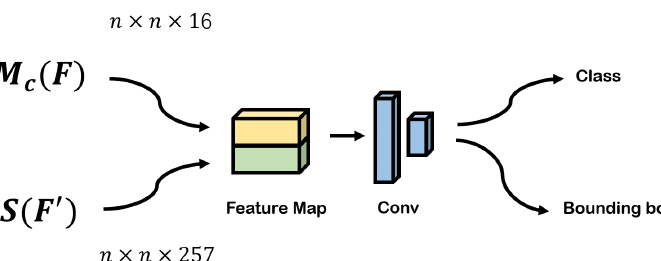
Figure 10. In the RoIHead (fast-rcnn) stage, the global semantic features M c ( F ) are fused with the local features S ( F (cid:48) ) from the saliency pyramid and RoIAlign by the convolutional